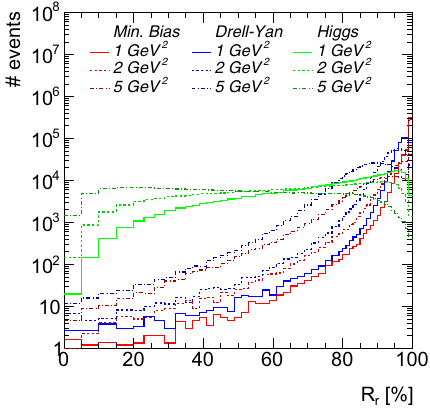
Fig. 6 A schematic diagram for how our model introduces trans- verse spacetime coordinates for the multiple parton interactions (black points), and for the end of the parton shower. Different coloured points are partons from different, respectively ring-coloured MPI centres. The thin black circles represent a characteristic scale for parton propagation about the MPI